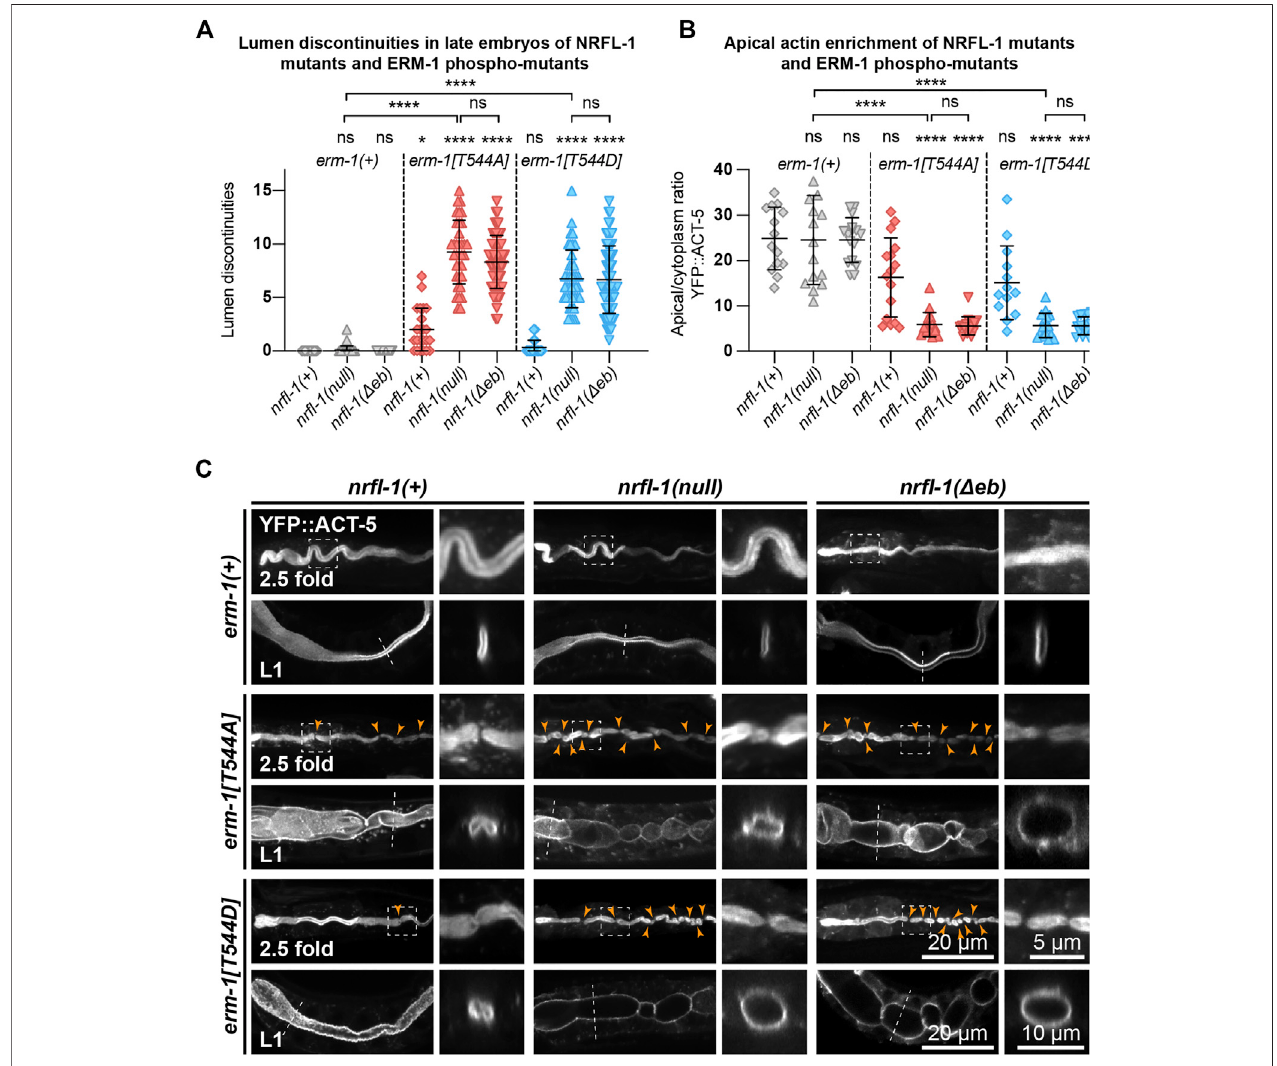
FIGURE 4 | ERM-1 phosphorylation and NRFL-1 redundantly contribute to intestinal morphology. (A) Quanti fi cation of lumen discontinuities in 2.5-fold stage embryos of indicated genotypes expressing YFP::ACT-5. Each data point represents a single animal. Error bars: mean ± SD. Statistical test: Kruskal-Wallis test with Dunn ’ s multiple comparison correction. nr fl -1(+); erm-1(+) n (cid:1) 19, nr fl -1(null); erm-1(+) n (cid:1) 35, nr fl -1( Δ eb); erm-1(+) n (cid:1) 48, nr fl -1(+); erm-1[T544A] n (cid:1) 23, nr fl -1(null); erm-1[T544A] n (cid:1) 35, nr fl -1( Δ eb); erm-1[T544A] n (cid:1) 61, nr fl -1(+); erm-1[T544D] n (cid:1) 28, nr fl -1(null); erm-1[T544D] n (cid:1) 41, nr fl -1( Δ eb); erm-1[T544D] n (cid:1) 69. (B) Quanti fi cation of the apical – cytoplasm ratio of YFP::ACT-5 in L1 larvae of indicated genotypes. Each data point represents a single animal. Error bars: mean ± SD. Statistical test: Kruskal-Wallis test with Dunn ’ s multiple comparison correction. nr fl -1(+); erm-1(+) n (cid:1) 14, nr fl -1(null); erm-1(+) n (cid:1) 15, nr fl -1( Δ eb); erm-1(+) n (cid:1) 16, nr fl - 1(+); erm-1[T544A] n (cid:1) 16, nr fl -1(null); erm-1[T544A] n (cid:1) 16, nr fl -1( Δ eb); erm-1[T544A] n (cid:1) 16, nr fl -1(+); erm-1[T544D] n (cid:1) 13, nr fl -1(null); erm-1[T544D] n (cid:1) 16, nr fl - 1( Δ eb);erm-1[T544D]n (cid:1) 16. (C) Representativeimagesofintestinaldefectsin2.5-foldstageembryosandL1larvaeofindicatedgenotypes,expressingYFP::ACT-5as an apical marker. Images of the 2.5-fold stage embryos were computationally straightened, and the orange arrowheads indicate the constrictions in the lumen. Small panels to the right of each embryo panel show an enlargement of the region indicated by the dashed box, and small panels to the right of each L1 larva show a cross- section view of the intestine at the position indicated by the dotted line. All images are taken using a spinning-disk confocal microscope, and maximum intensity projections are presented.